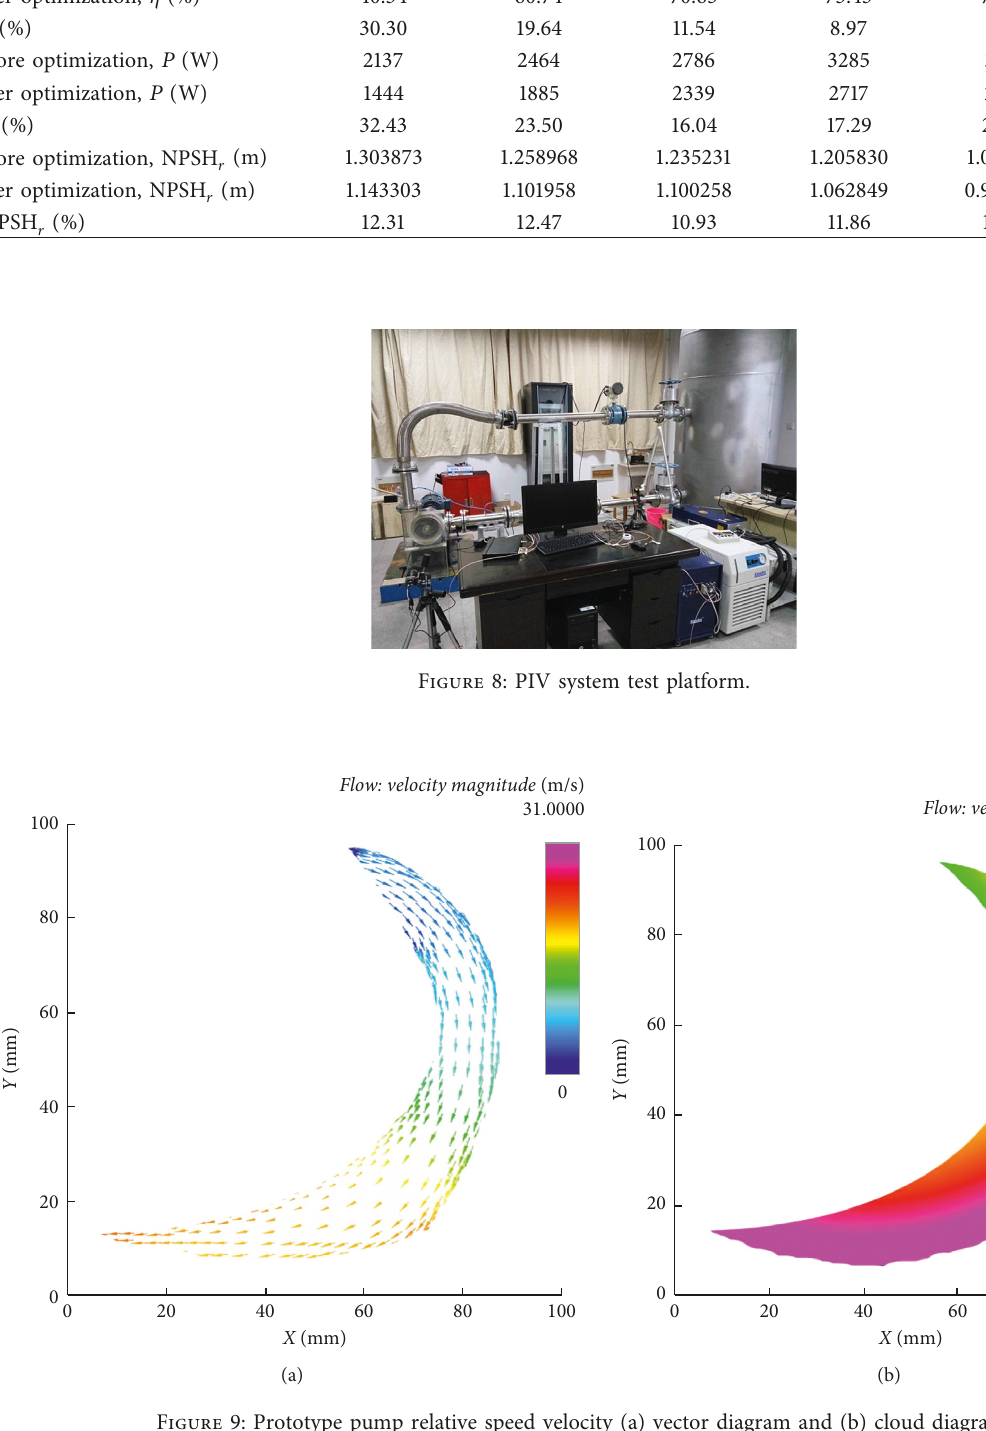
Figure 9: Prototype pump relative speed velocity (a) vector diagram and (b) cloud